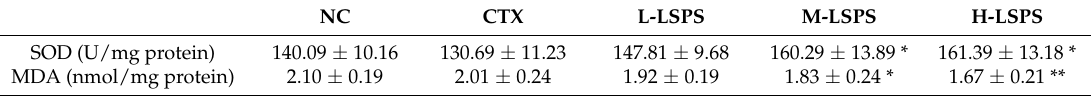
Table 1. Effect of LSPS on SOD activity and MDA level in the liver of H22 tumor-bearing mice. NC CTX L-LSPS M-LSPS H-LSPS SOD (U/mg protein) 140.09 ±